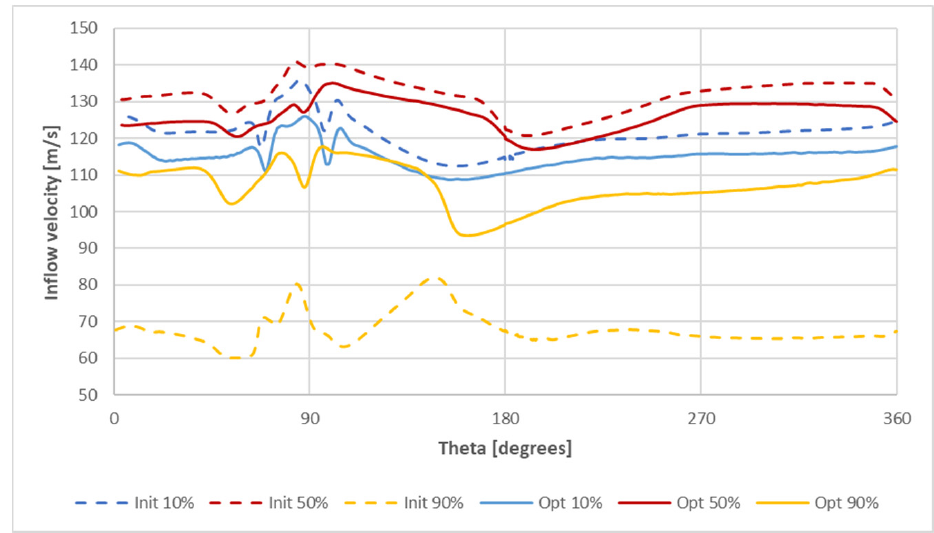
Figure 15. Circumferential distribution of the axial velocity component for different positions in initial (dashed line) and optimized (solid line) geometries.